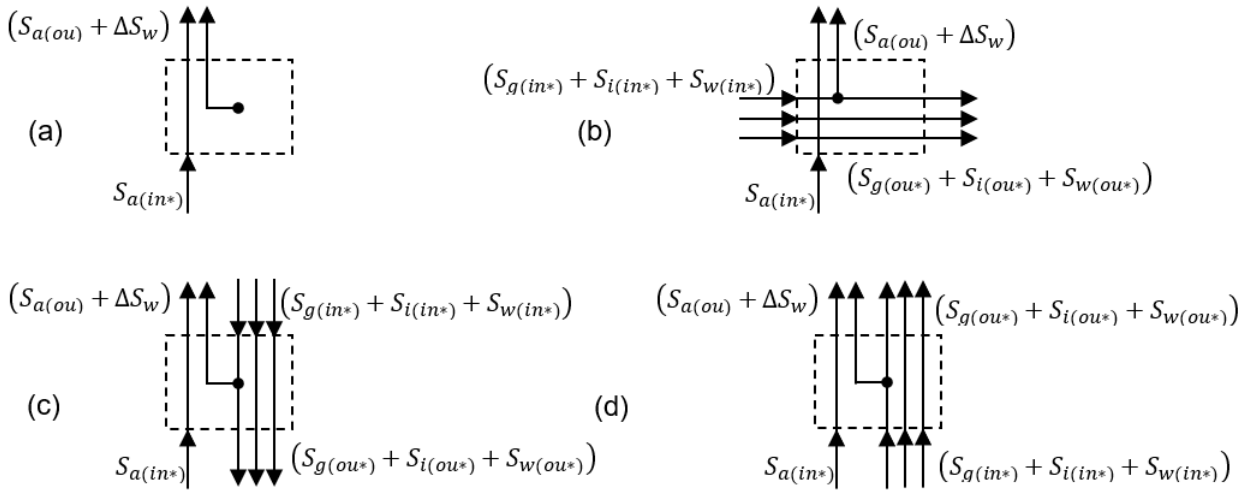
Figure 4. Classification of drying models. ( a ) Immobile grain layer; ( b ) cross ‐ flow; ( c ) counter ‐ flow; ( d ) parallel ‐ flow.